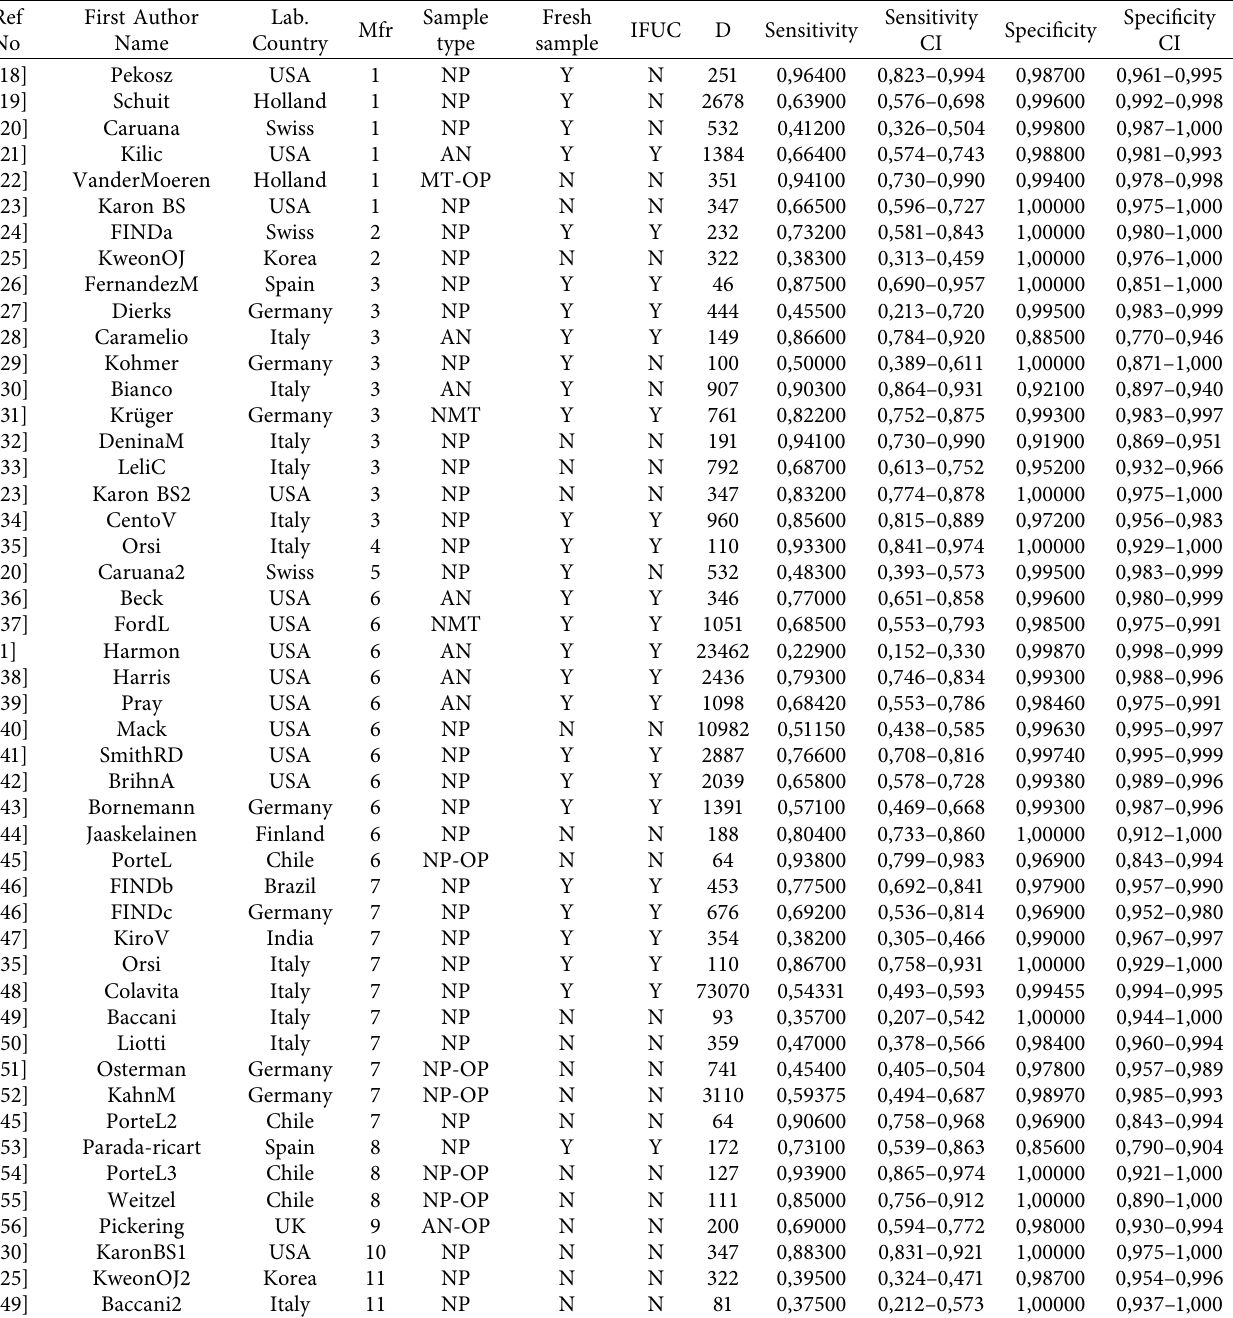
Table 1: Clinical sensitivity and specificity data for instrument-read rapid antigen tests (Ag-IRRDTs) against